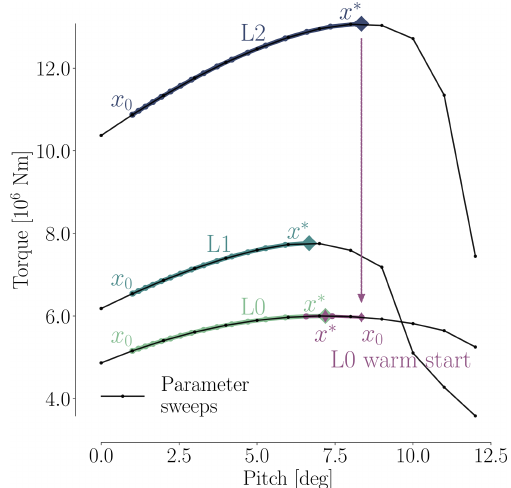
Figure 7. Variation of torque with the pitch design variable.